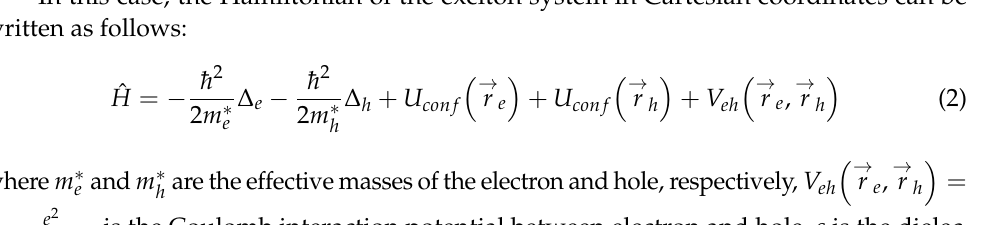
Figure 1. Schematic figure of the conical quantum dot.